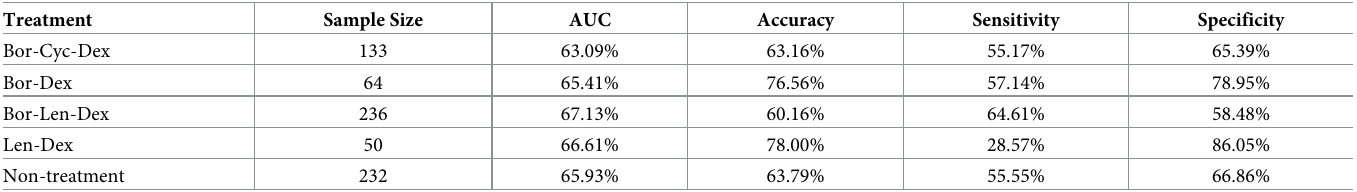
Table 2. Classification performance metrics per treatment on 10-fold CV. Sample size describes the amount of patients annotated with the correspondent treatment. All CV validation data sets were combined into a unique data set to compute these metrics.